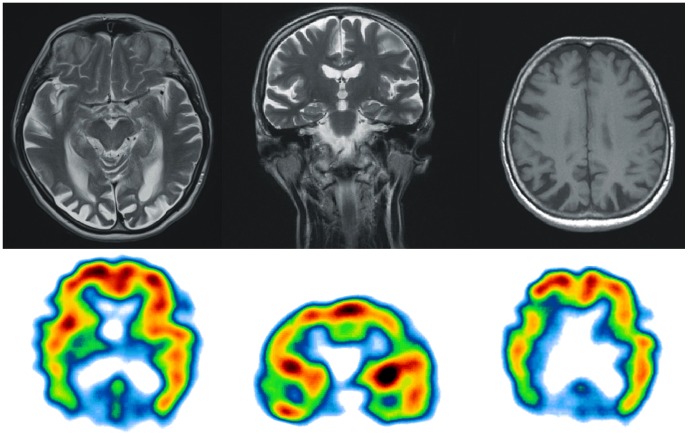
Results of MRI and SPECT examinations of the proband.Magnetic Resonance Imaging revealed marked cortical and subcortical atrophy within both occipital and parietal lobes bilaterally. The atrophy was less pronounced in the frontal and temporal lobes, and the hippocampal structures of the temporal lobes were mostly preserved. Single Photon Emission Computed Tomography demonstrated severe hypoperfusion within the parietal, occipital and temporal lobes bilaterally.